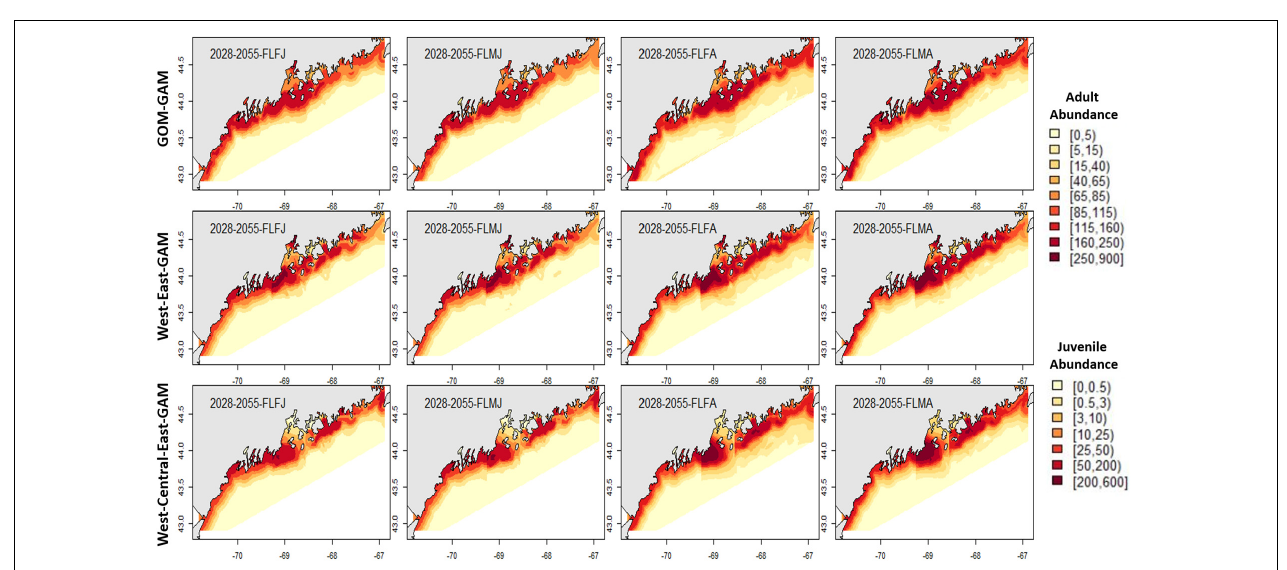
FIGURE 5 | Forecasted fall American lobster estimated spatial distribution for the time period 2028–2055. See Figure 4 for figure